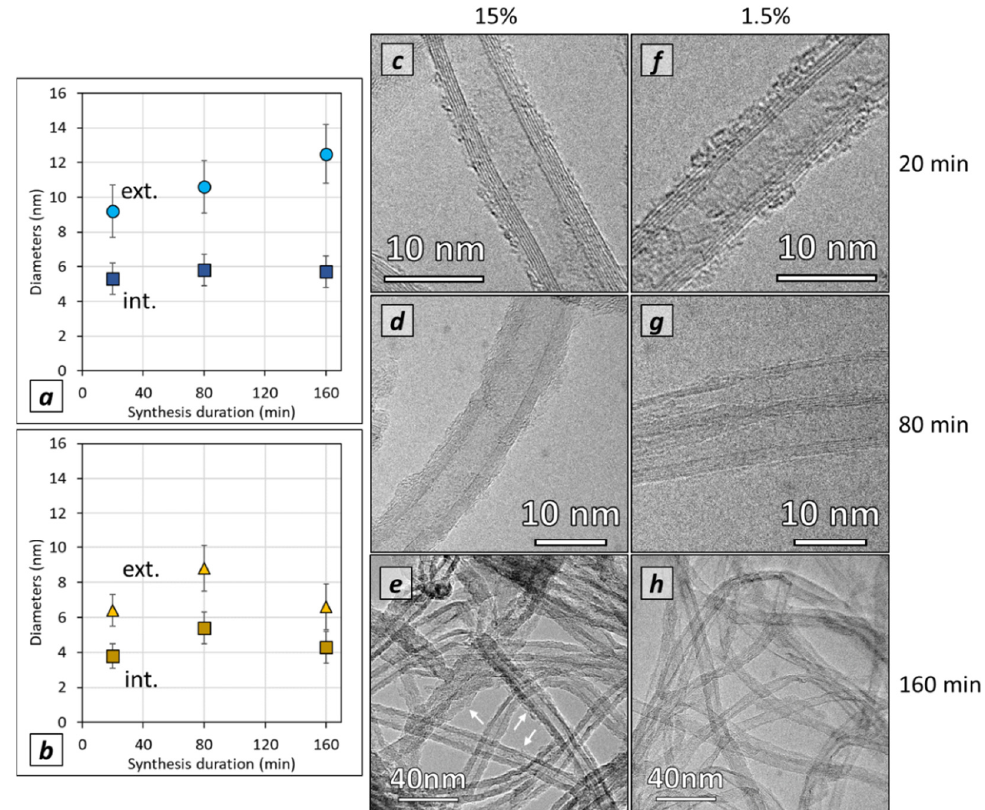
Figure 7. Average CNT external and internal diameter obtained on LG-Al substrates for: ( a ) high acetylene content (15 vol%), ( b ) low acetylene content (1.5 vol%). Measurements are performed by TEM on at least 100 CNTs observed; the mean values were calculated and reported together with the standard deviation (±2 σ ). TEM micrographs of CNT synthesized for ( c – e ) high acetylene content and ( f – h ) low acetylene content. Synthesis durations are ( c , f ) 20 min, ( d , g ) 80 min and ( e , h ) 160 min. White arrows indicate the presence of disorganized carbon.